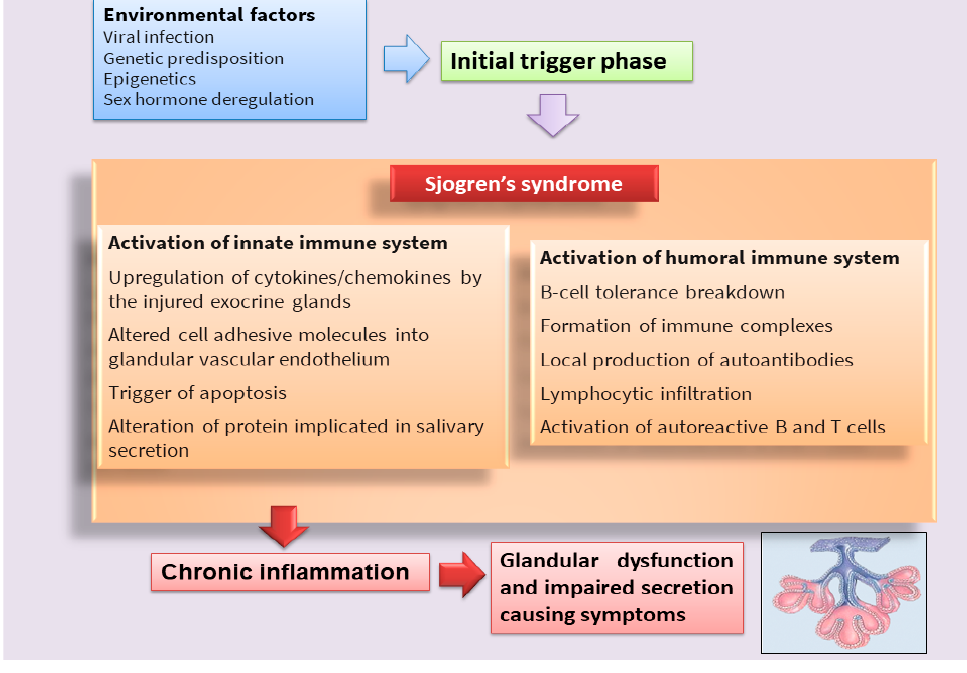
Figure 1. Scheme that clarifies the hypothetical onset of SS. Table 1. Schematic illustration of therapies used in SS.